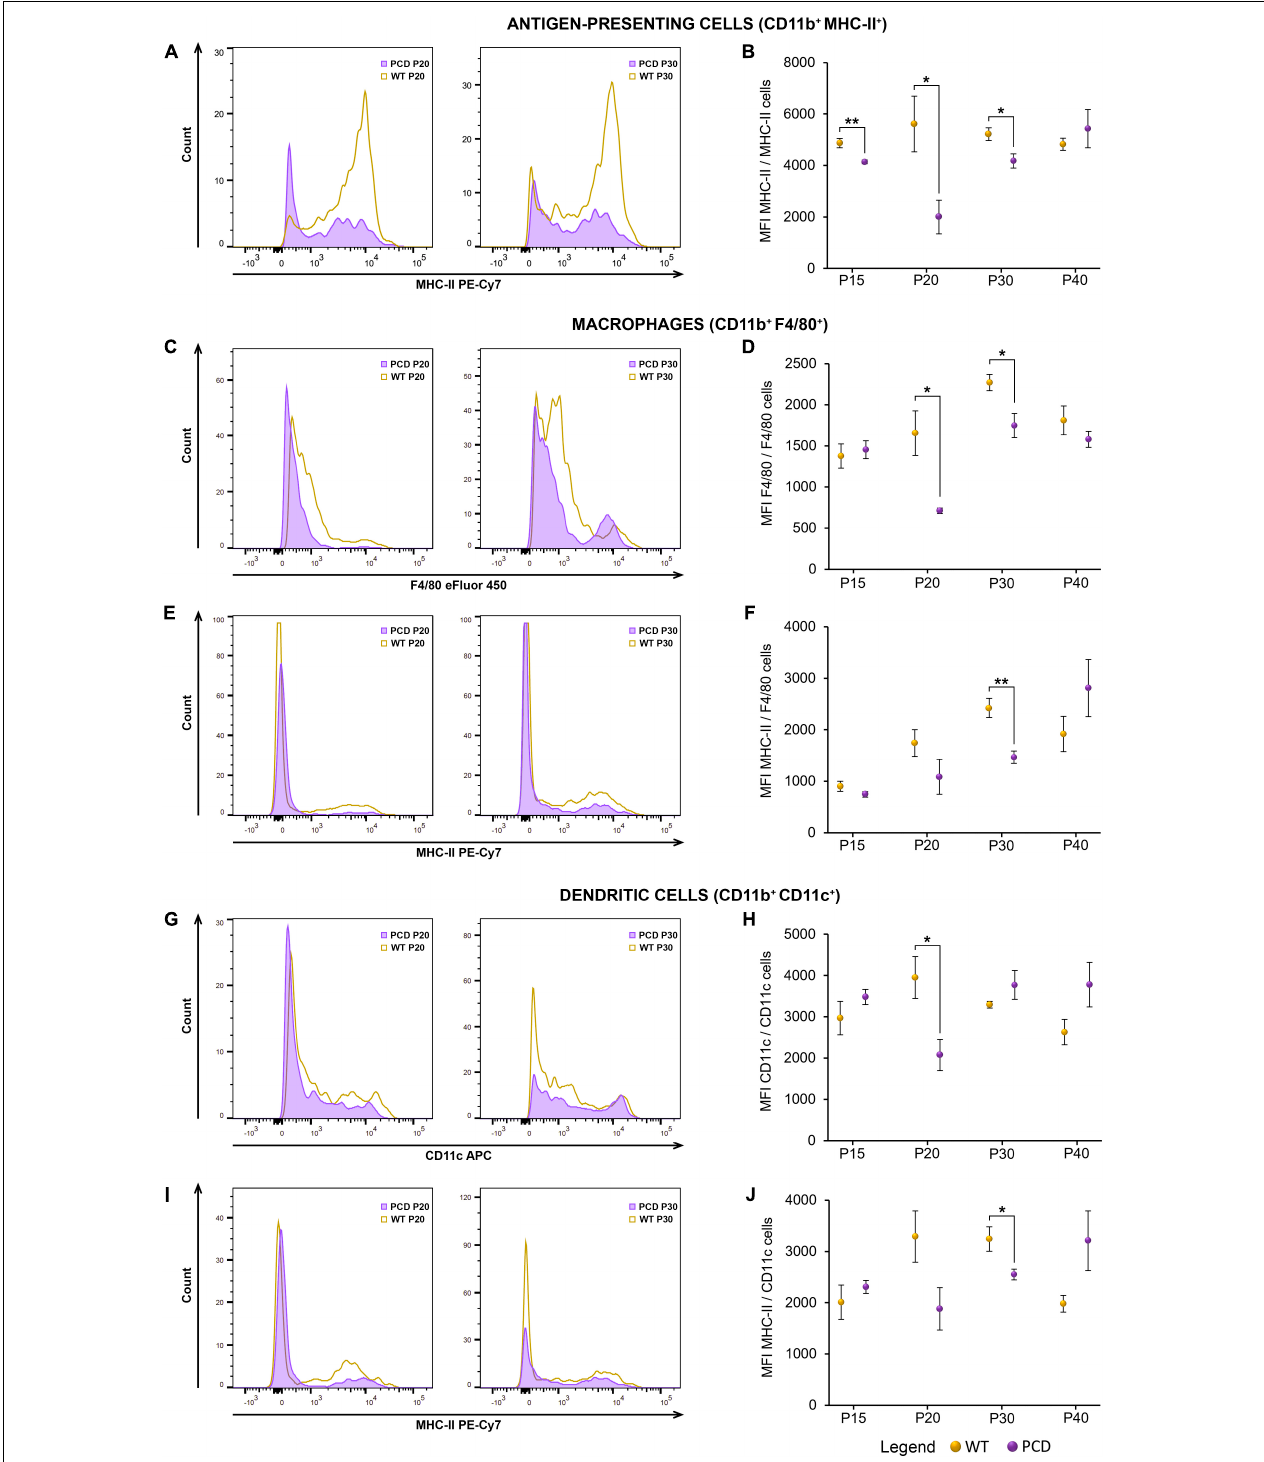
FIGURE 5 | Flow cytometry analysis of the MFI of different myeloid markers in the spleen of WT and PCD mice. (A,C,E,G,I) Representative histograms showing the distribution of the fluorescence intensity of several myeloid markers: MHC-II within the whole antigen-presenting cell population (A) , F4/80 and MHC-II respect to the whole macrophage subset (C,E) , and CD11c and MHC-II respect to the whole dendritic cell population (G,I) . (B,D,F,H,J) Charts showing the MFI of the markers and populations described in (A,C,E,G,I) . Note that the myeloid cells of PCD mice exhibited a general reduction in the MFI of several myeloid markers. Data are expressed as mean ± standard error of the mean. * p < 0.05; ** p <